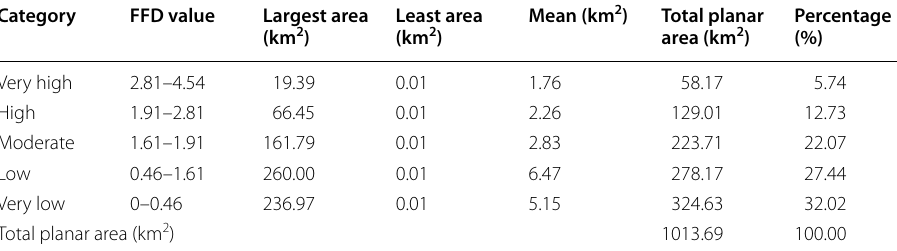
Table 2 Descriptive statistics FFD planar area measurements in five value categories in the study area Category